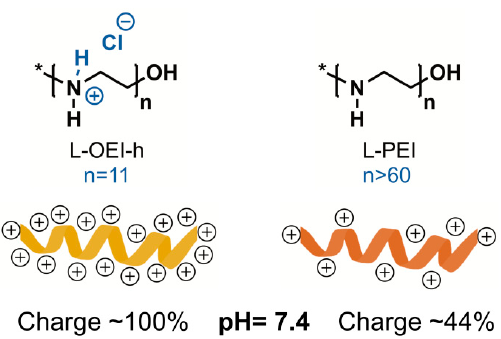
Figure 7. Comparison of positive charge density between linear oligoethyleneimine hydrochloride (L-OEI-h) and linear polyethyleneimine (L-PEI) at physiological pH.